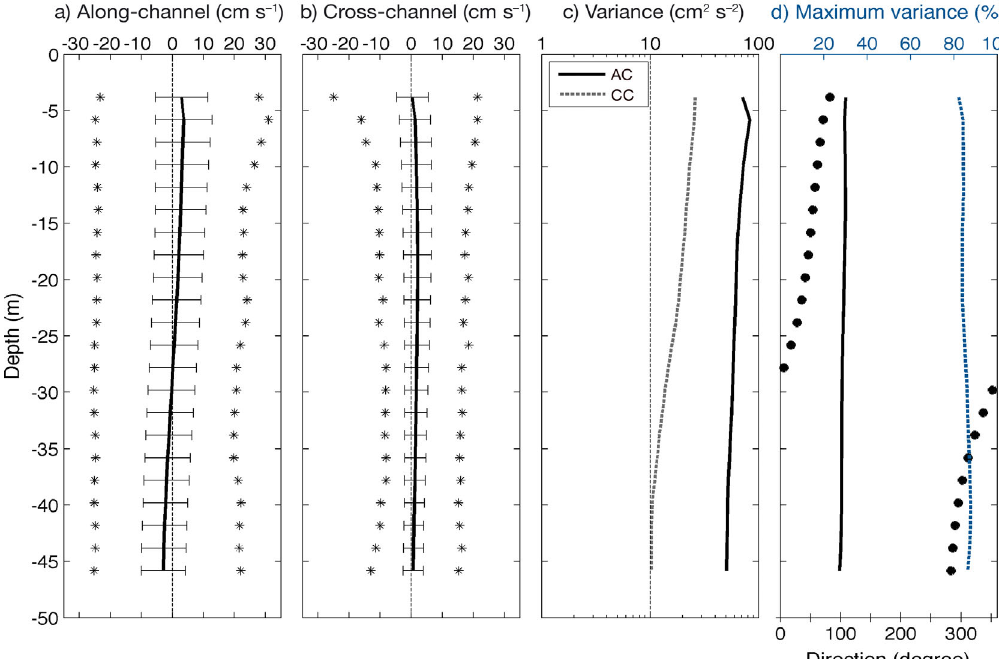
Fig. 3. (a,b) Mean vertical structure (continuous black line), standard deviation (error bars) and maximum and minimum val- ues ( ) of the total current in the along- (AC) and cross-channel (CC) axes, respectively. (c) Variance in both components. (d) Mean flow direction (black dots), percentage of explained variance by major principal axis (MPA, i.e. the maximum variance of the total current; blue line) and orientation of the MPA (black line). Caucahue Channel, 17 April to 21 July